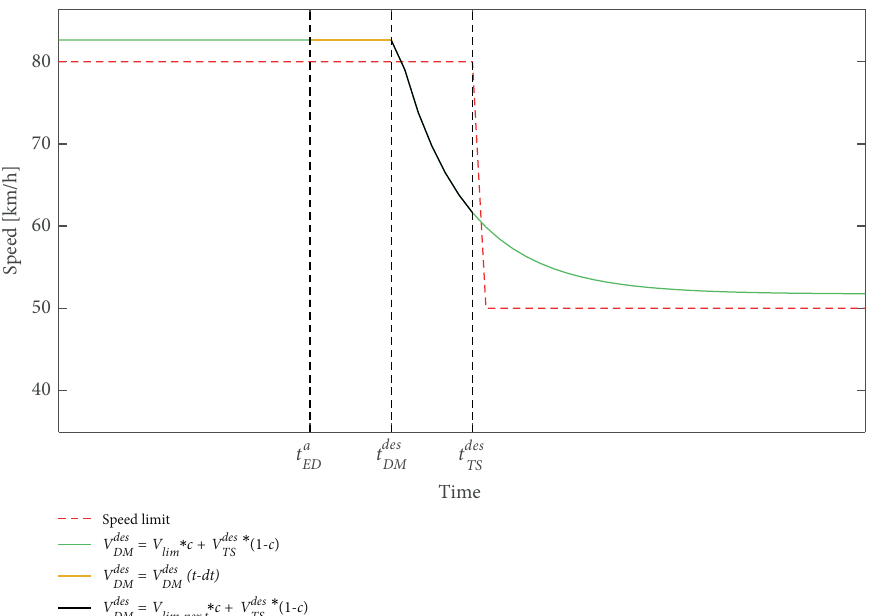
Figure 3: Example of how the desired speed may vary during the deceleration phase for a 50% compliant driver with the desired speed 10% above the speed limit given a speed advice equal to the speed limit. Note that the time is related to the time when the driver is expected to reach the speed limit change.